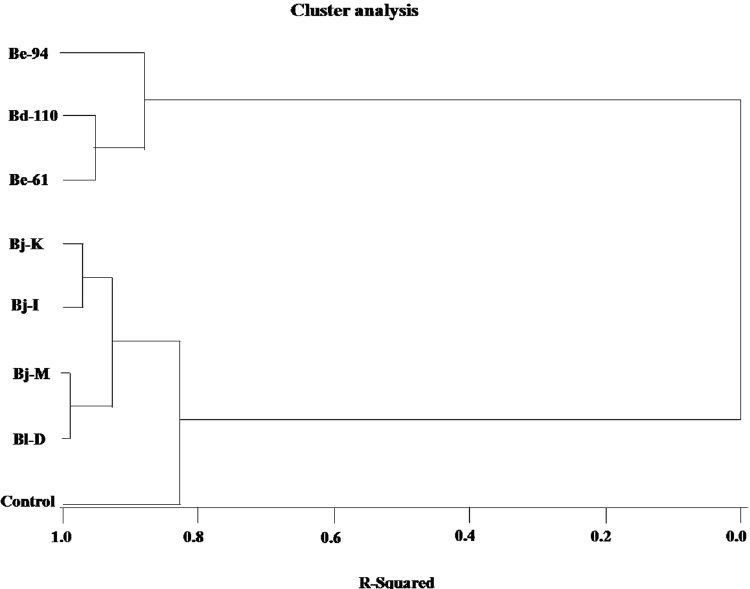
Figure 5. Multivariate analysis based on Ward’s minimum variance cluster analysis showing the effects of inoculation of Rtx and non-Rtx bradyrhizobial strains on plant rhizosphere and growth parameters in soybean plants under combined watered and water-stressed conditions using the CLUSTER procedure and the software package SAS